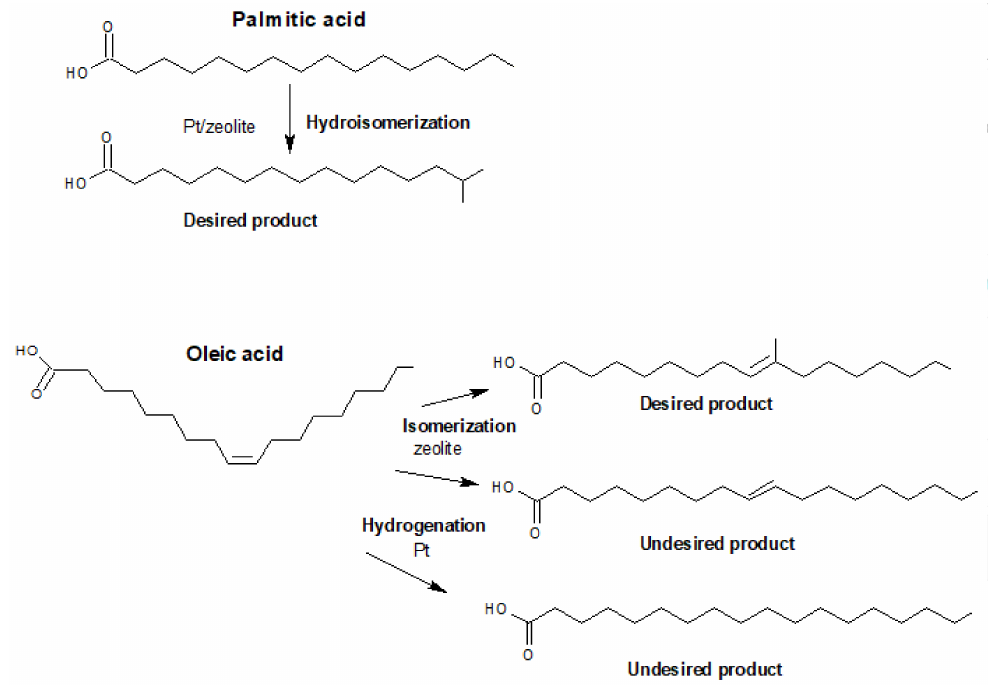
Figure 1. Desired and undesired products from the isomerization/hydroisomerization of oleic acid and the hydroisomerization of palmitic acid (modified from Reference